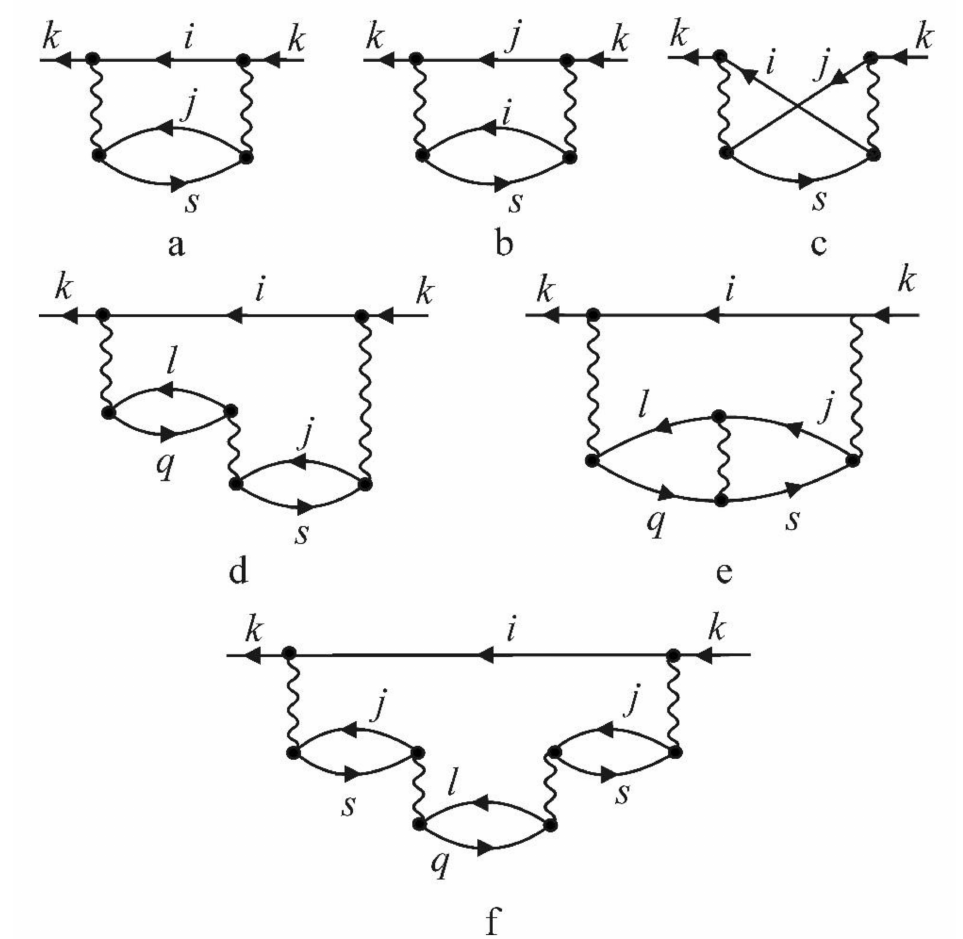
Figure 2. Feynman diagrams for the spectral function in a simplified forth-order approach. ( a – c ) Direct and exchange second-order diagrams, ( d , e ) direct and exchange third-order diagrams for the decay of satellite into continuum, ( f ) fourth-order diagram (exchange parts are not